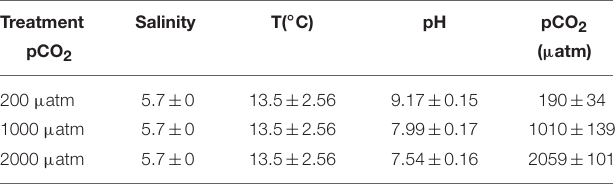
TABLE 1 | Environmental variables (salinity and temperature) and carbonate parameters pCO 2 ( n = 10) and pH NBS ( n = 10) in different treatments measured during the experimental period in 2013.